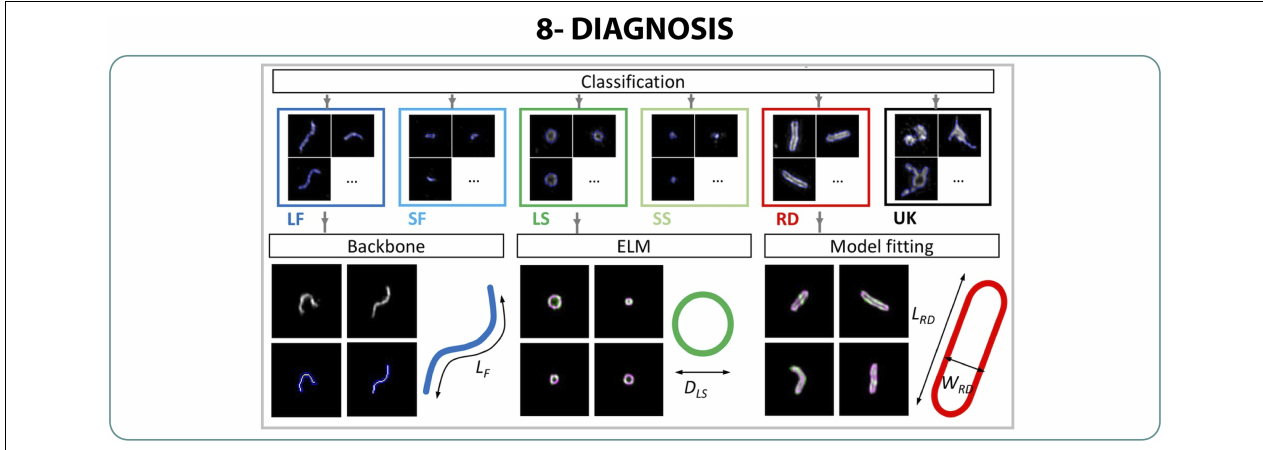
FIGURE 9 | Diagnosis. Workflow of the automated detection and classification method using TIRF-SIM to classify NDV shape in high-throughput (Laine et al.,